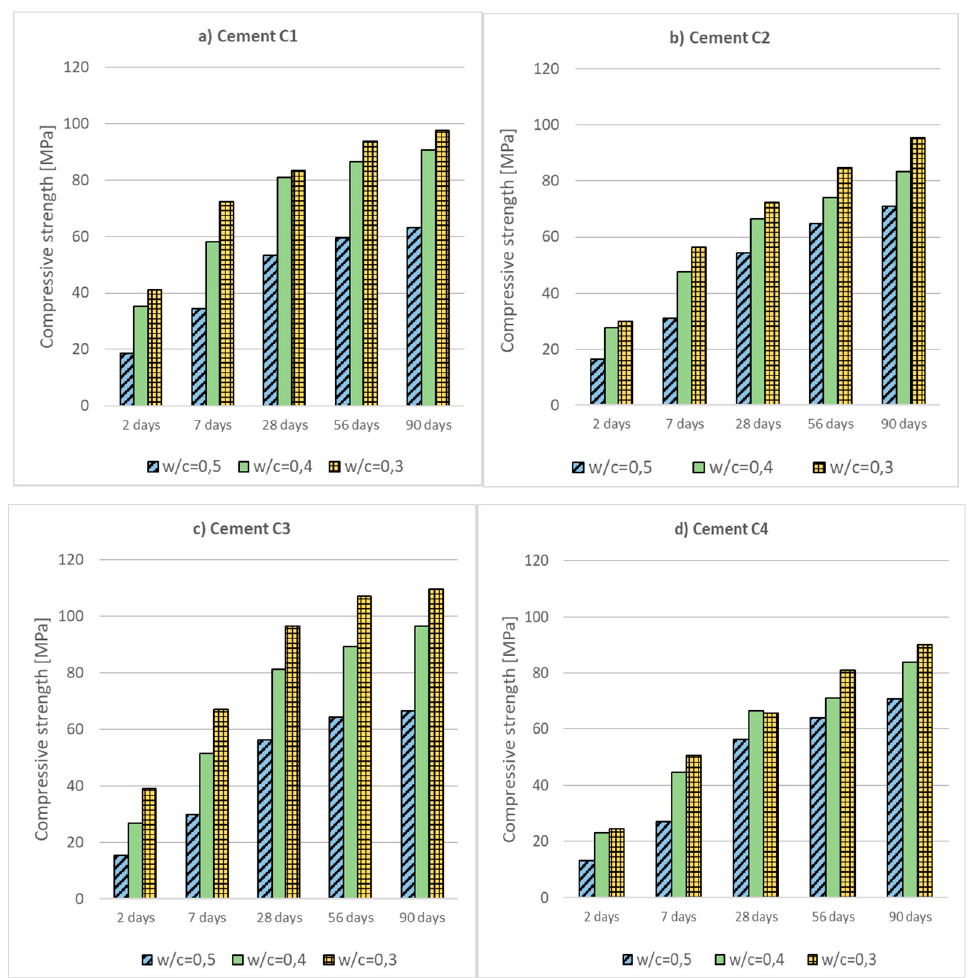
Figure 3. Compressive strength of cements with different w/c ratio: ( a ) Cement C1; ( b ) Cement C2; ( c ) Cement C3; ( d ) Cement C4.